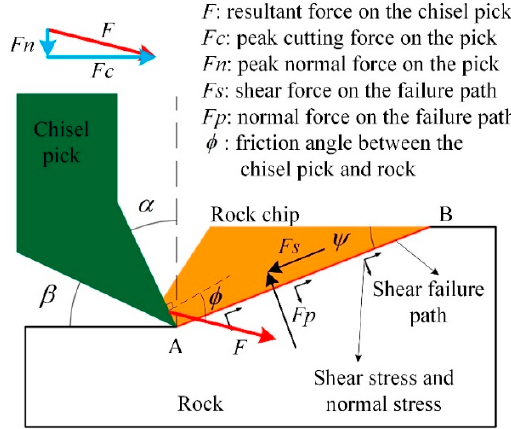
Figure 3. Illustration of Nishimatsu’s model for rock cutting with a chisel pick.